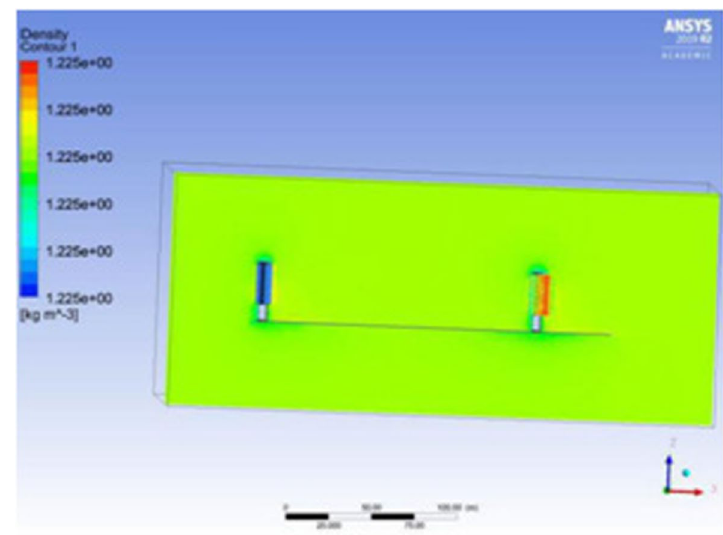
Fig. 6 Vertical wind turbine positioned on the main shaft of the ship (Vasilescu and Dinu 2020)